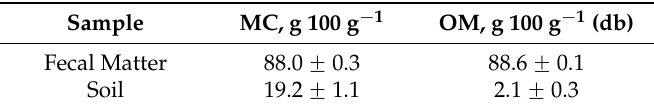
Table 1. Compositional indices, with standard deviations, of fecal matter and soil samples. MC, moisture content; OM, organic matter content; db, dry basis.